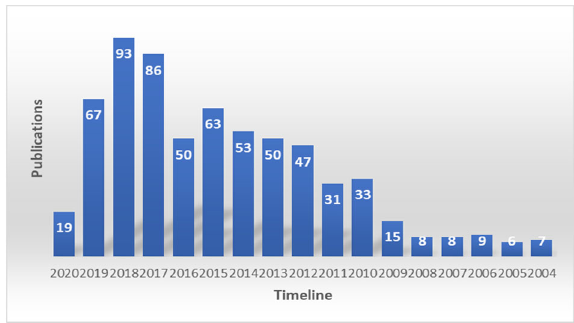
Fig. 1 Cumulative publications on the microneedle drug delivery system. The analysis was done by the PubMed database using the search term “ microneedle drug delivery ”